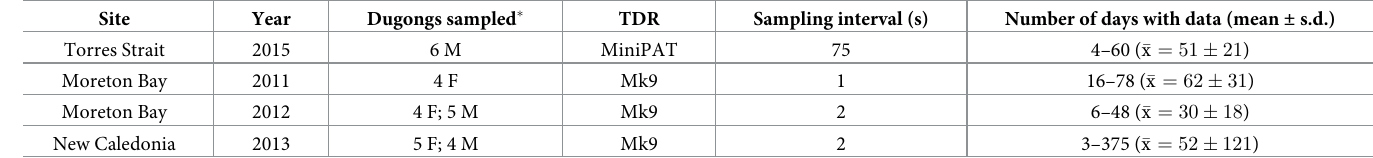
since the 1980s [33, 39]. Procedures for capturing, handling and attaching the tracking units followed Sheppard et al. [18] in Moreton Bay and New Caledonia or Fuentes, Cleguer [40] in Torres Strait. Details of individual dugongs are provided in S1 Table. The GPS satellite transmitters were programmed to communicate with satellites every hour (25 animals) or 30 min (three animals deployed in Moreton Bay) (S1 Fig). The TDRs recorded depths every 1–2 s (Mk9) or 75 s (MiniPAT). Each MiniPAT was programmed to transmit the data to the satellites upon detachment after 60 days or upon earlier detachment. The Mk9 units were recovered for data retrieval. The GPS location data were retrieved from the Argos web site and decoded using the Telonics Data Converter; the Wildlife Computers portal was used to obtain the MiniPAT data. We used only high-quality location data: GPS fixes (± 2 to < 10 m) and resolved Quick Fix Pseudoranging (QFP) fixes (± < 75 m) for further analysis. The dive records from the Mk9 units were decoded by HexDecode. The sources of error in the depth records included: 1) drift in zero-reading; 2) wave action; 3) the depth resolution of the depth sensors; 4) the location of the depth sensors attached to the animals; and 5) the angle of animals’ body. Thus the depth records were zero-offset at each 10-min interval using custom software [41]. We assumed that the depth records collected by the Mk9 TDRs and MiniPATs were equiva- lent because: 1) both devices were made by the same manufacturer and had 0.5 m depth sensor resolution, 2) the accuracy of the depth records were tank-tested at a local 15m deep aquarium, and 3) the reliability of the depth profile provided by the maximum memory capacity of the MiniPATs (60 days) was confirmed by sub-sampling the depth records collected by the Mk9 TDRs assuming that the depth records were collected at the same frequency as the MiniPATSs (75sec) using the 1 sec Mk9 TDR sampling frequency as the standard. Some GPS transmitters and a MiniPAT were prematurely released from the dugongs due to unknown reasons or the